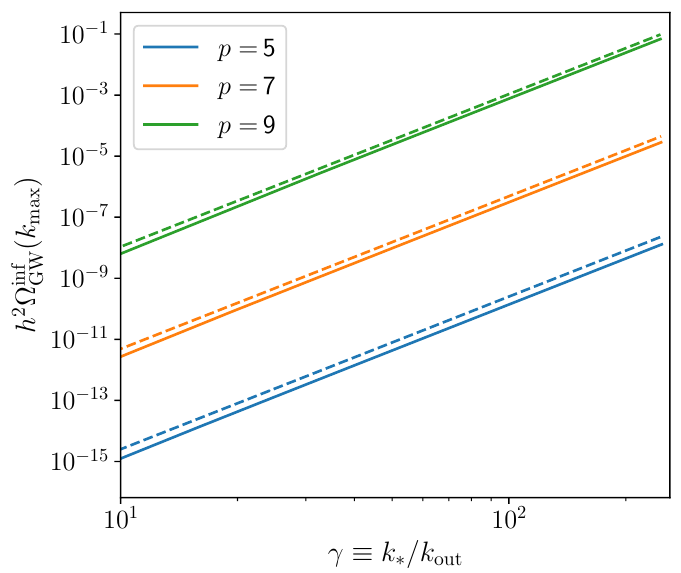
Figure 5 . Scaling of the peak in Ω inf as a function of γ . Coloured lines correspond to h 2 Ω inf eval- GW GW uated at the maximum (4.50) (computed for the two-field example in section 4.7 without the approx- imation of peaked Bogoliubov coefficients), for different enhancement of the primordial scalar power spectrum p ≡ 1 / 2 ln( P ζ / P 0 ) and fixed (cid:15) = 10 − 2 . Each dashed line corresponds to 10 − 2 N 2 (cid:15) 2 γ 5 Ω rad √ GW evaluated at k = 2 k ∗ / 3 , which is the location of the maximum of the scalar-induced GWs sourced during radiation. A given p translates into a fixed Ω rad maximum amplitude. The figure confirms GW very accurately the scaling obtained with the simple analytical estimate in eq.